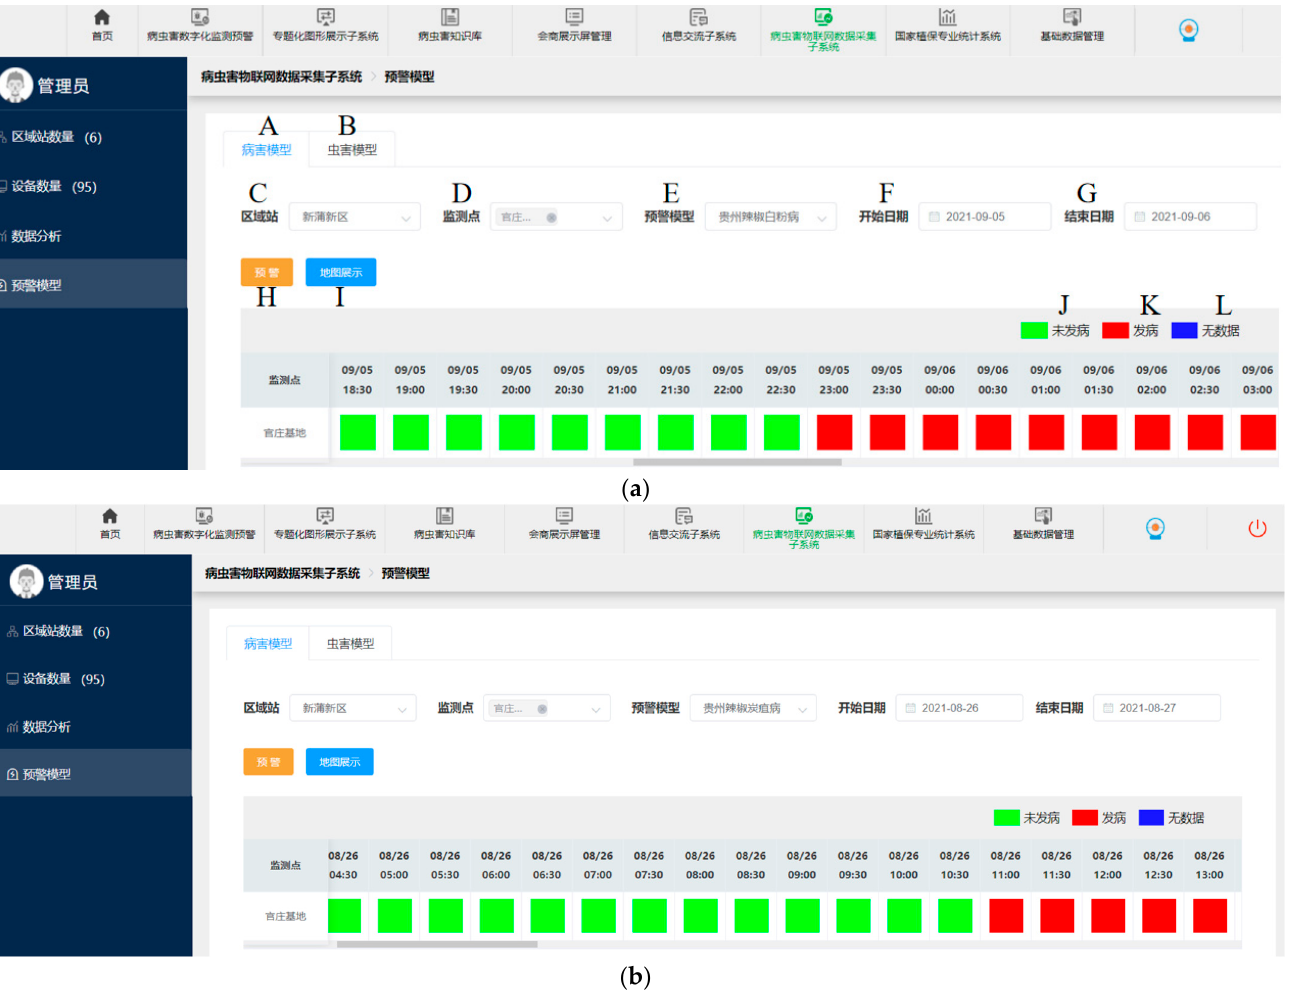
Figure 8. Interface of the hot pepper disease and pest forecast system in Guizhou. ( a ) Powdery mildew forecast interface; and ( b ) Anthracnose forecast interface. (A) Disease model; (B) Pest model; (C) Regional stations; (D) Monitoring points; (E) Early warning model; (F) Start date; (G) End date; (H) Provide an early warning; (I) Map display; (J) Disease will not occur; (K) Disease will occur; and (L) No data.